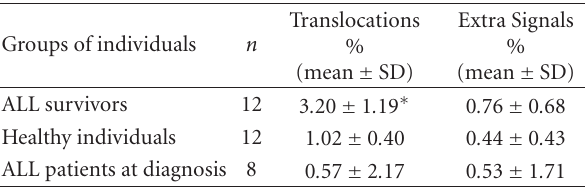
Table 1: Mean frequency of ETV6/RUNX1 translocations and extra signals obtained for ALL survivors, healthy individuals, and patients at the time of initial diagnosis [20].